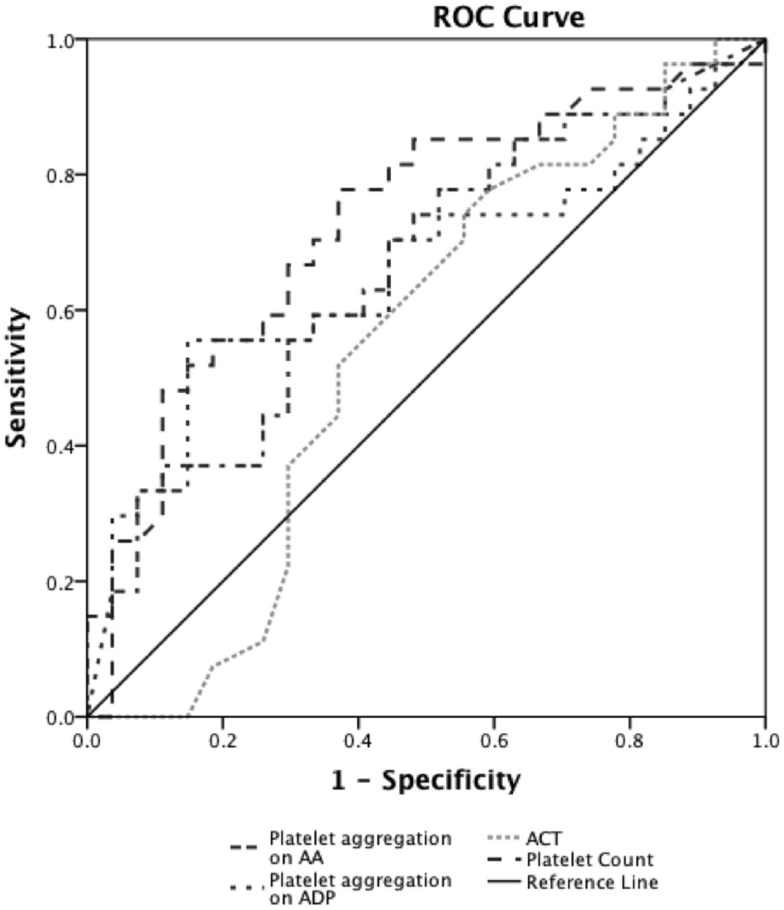
Receiver operator curve analyses for hemostatic parameters to predict mortality. On ROC analyses (n = 24), we found that the AUC for ACT (0.51, 0.35–0.67, p = 0.9) was the lowest compared to quantitative platelet count (0.73, 0.59–0.86, *p = 0.004) and TEG®–PM parameters of qualitative platelet function [ADP-mediated platelet aggregation (0.67, 0.52–0.8, *p = 0.03) and AA-mediated platelet aggregation (0.65, 0.50–0.80, p = 0.06)]. *p < 0.05 considered significant.